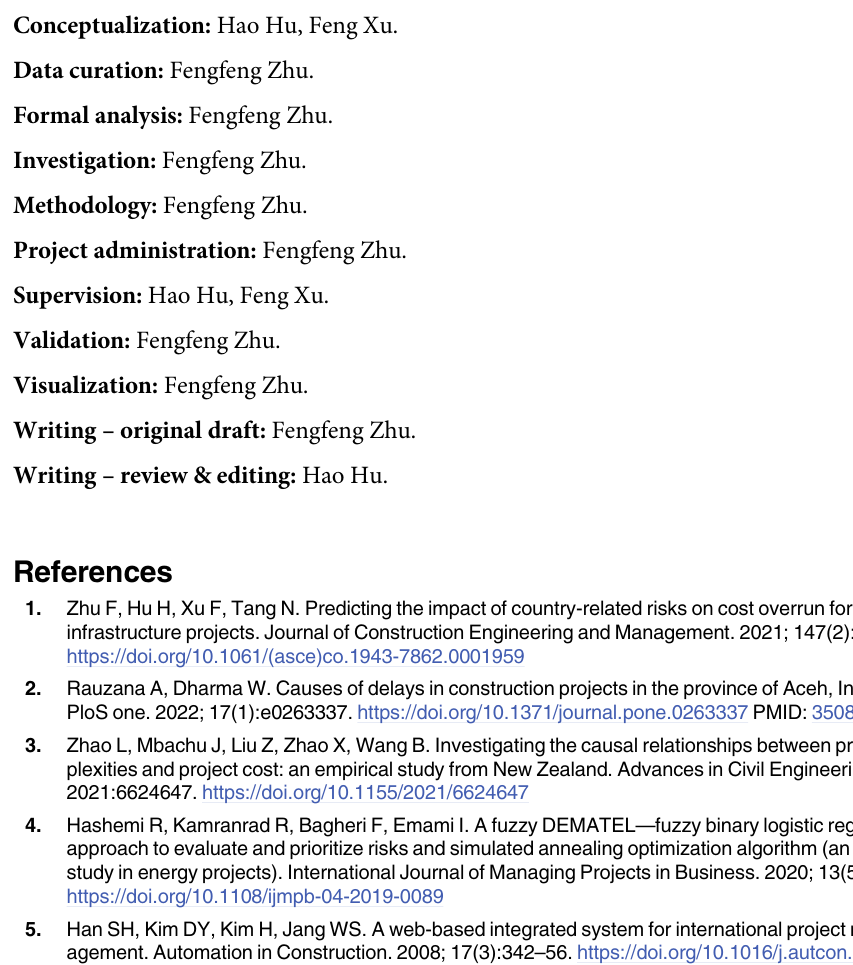
S2 Fig. Risk networks of Project 2. S3 Fig. Risk networks of Project 3. S4 Fig. Risk networks of Project